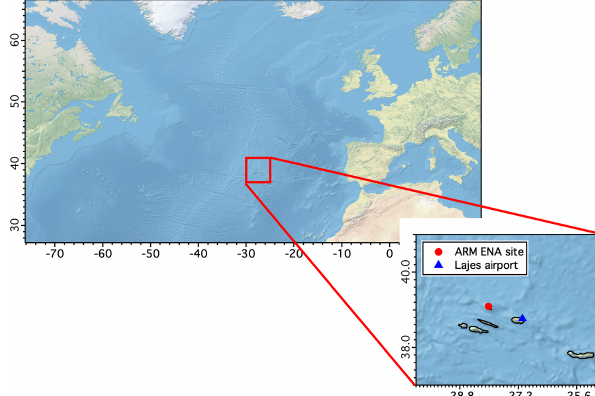
Figure 1. Geographical location of the Azores archipelago, the site of the ACE-ENA campaign. The map was created using public domain map data on Natural Earth (https://www.naturalearthdata. com/, last access: 12 March 2020) and the GSHHG database (https: //ngdc.noaa.gov/mgg/shorelines/, last access: 12 March